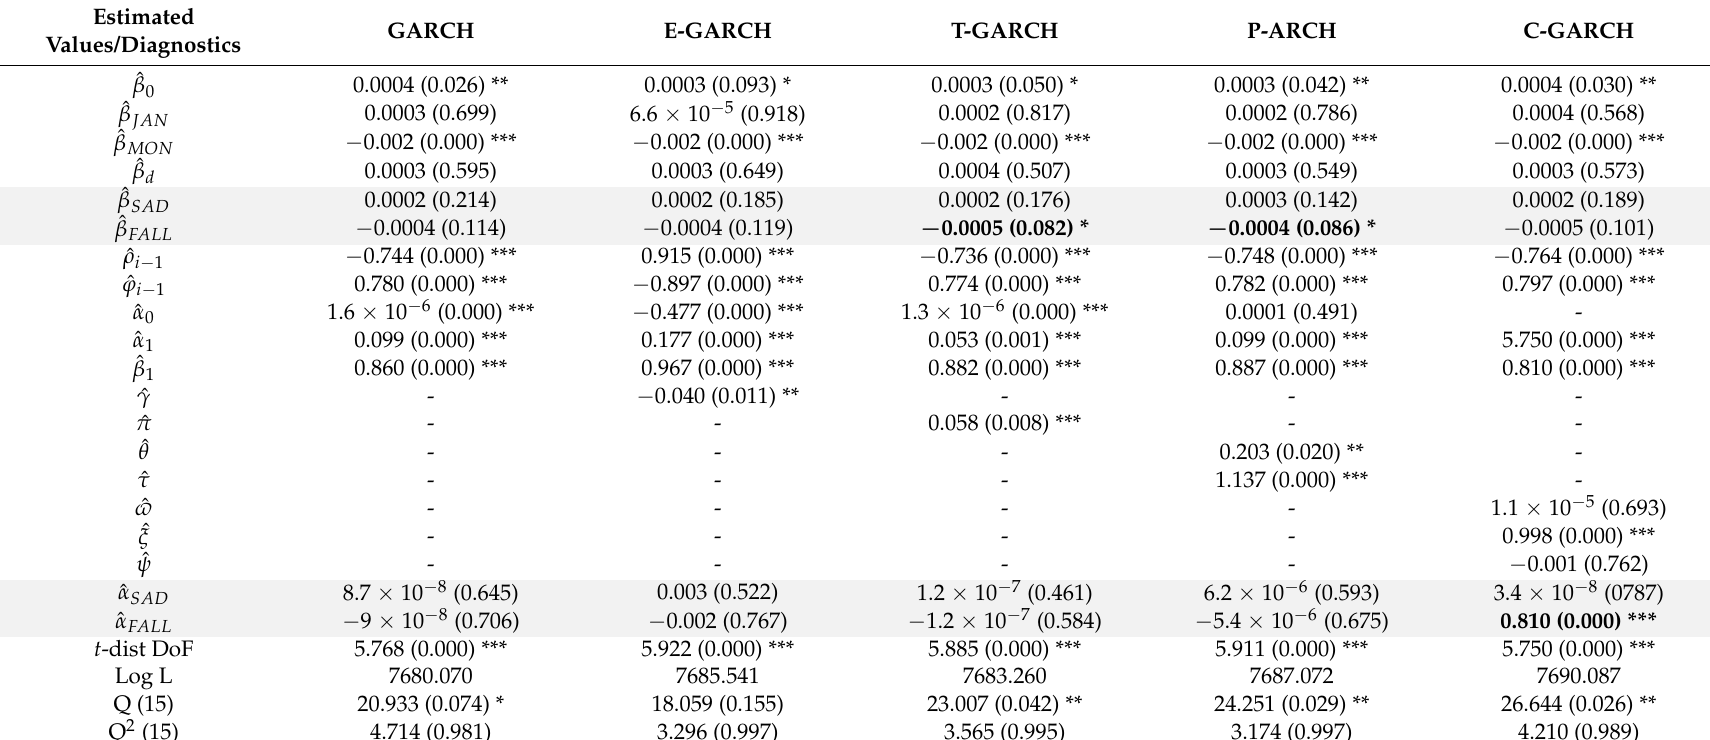
Table A5. Different GARCH specifications for CROBEX 9